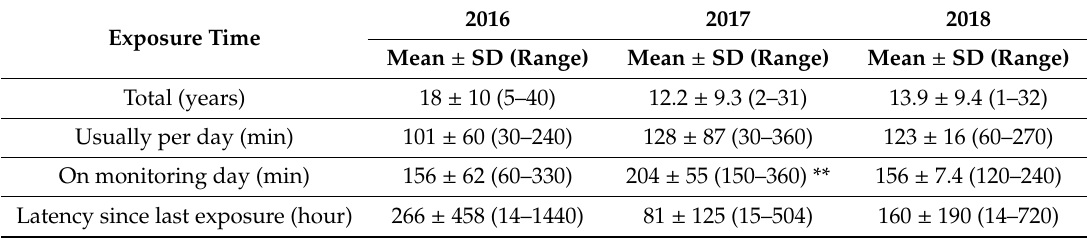
Table 2. Exposure characteristics of the complete researchers’ groups for 3